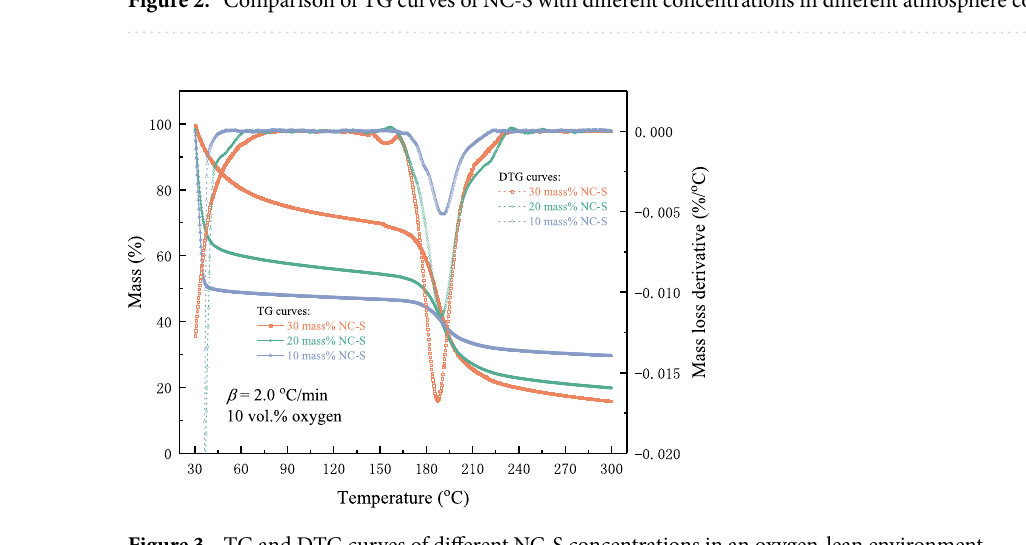
Figure 3. TG and DTG curves of different NC-S concentrations in an oxygen-lean